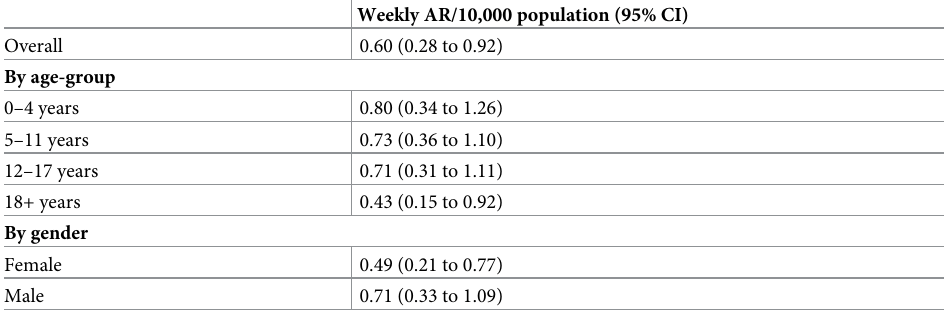
Table 3. Attack rate of reported AJS cases by age-group � and gender among all 34 camps between 28 February and 26 March 2018 in Cox’s Bazar, Bangladesh.